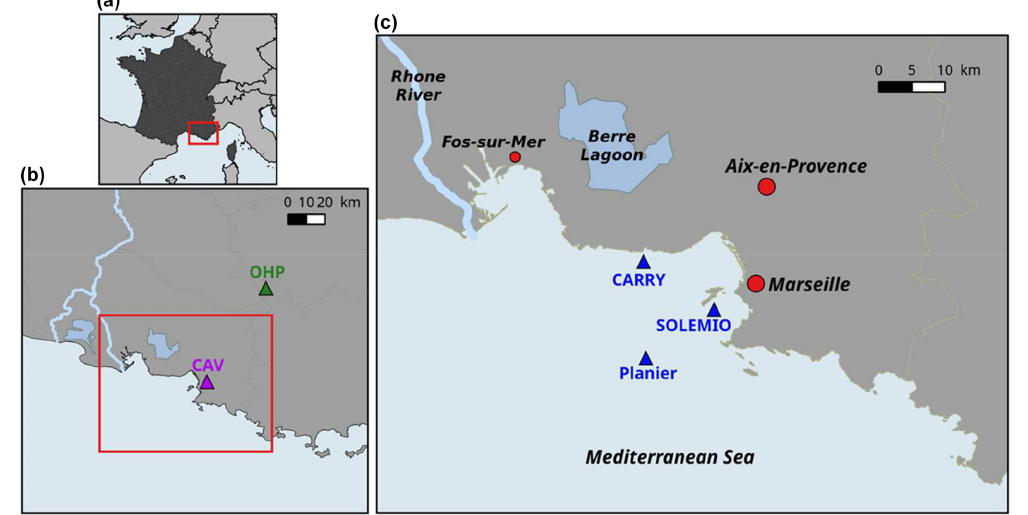
Figure 2. Map of study area: the Region Sud (a) , Aix–Marseille Metropolis (area in the red rectangle) (b) , the Bay of Marseille (c) . CAV = Cinq Avenues Station (urban site); OHP: Observatoire de Haute Provence station (non-urban site); Carry, Solemio, Planier: marine study sites in the Bay of